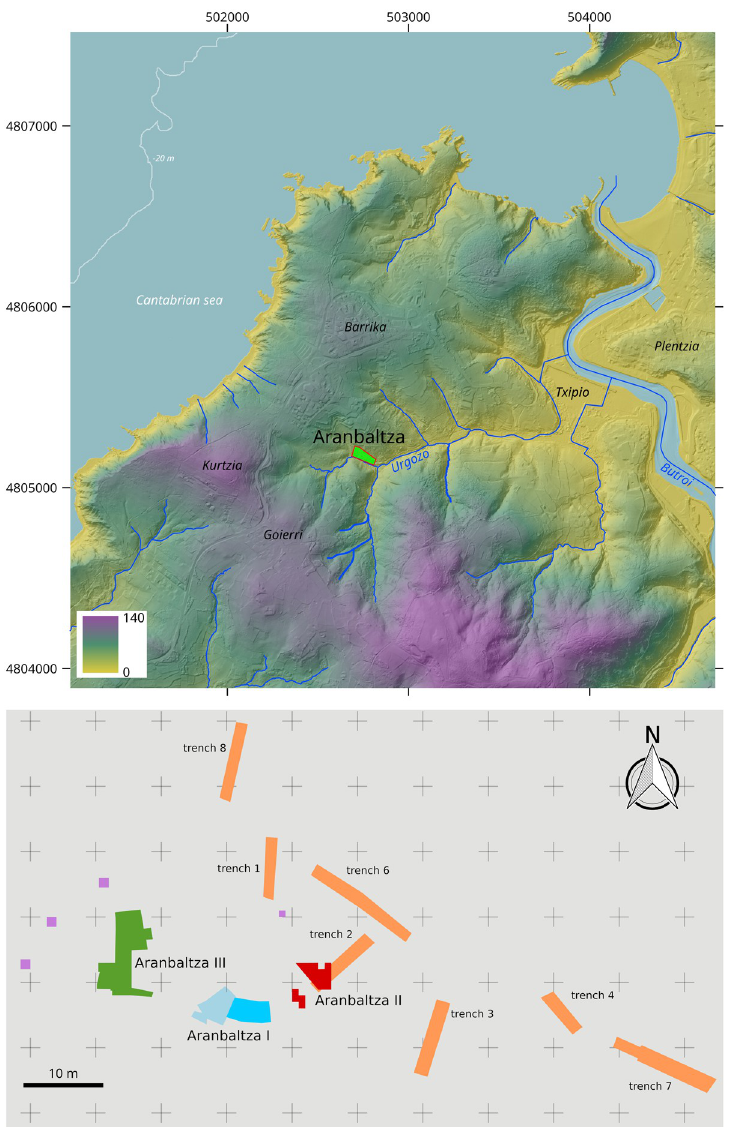
Fig 2. Aranbaltza location maps. A) Digital Elevation Model showing the position of Aranbaltza site; B) Excavation plan, with the area of the excavated Chaˆtelperronian deposits in red. Base cartographic data obtained from National Geographic Institute of Spain (IGN) under the Creative Commons License CC-BY 4.0. DEM built up with ArcGis 10.3. Infographics made with